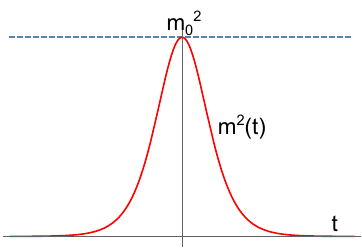
Figure 2 . A mass-pro(cid:12)le describing quantum quench from a critical Hamiltonian back to the critical Hamiltonian. Here m 2 ( t ) t !(cid:6)1 (cid:0)(cid:0)(cid:0)(cid:0)!